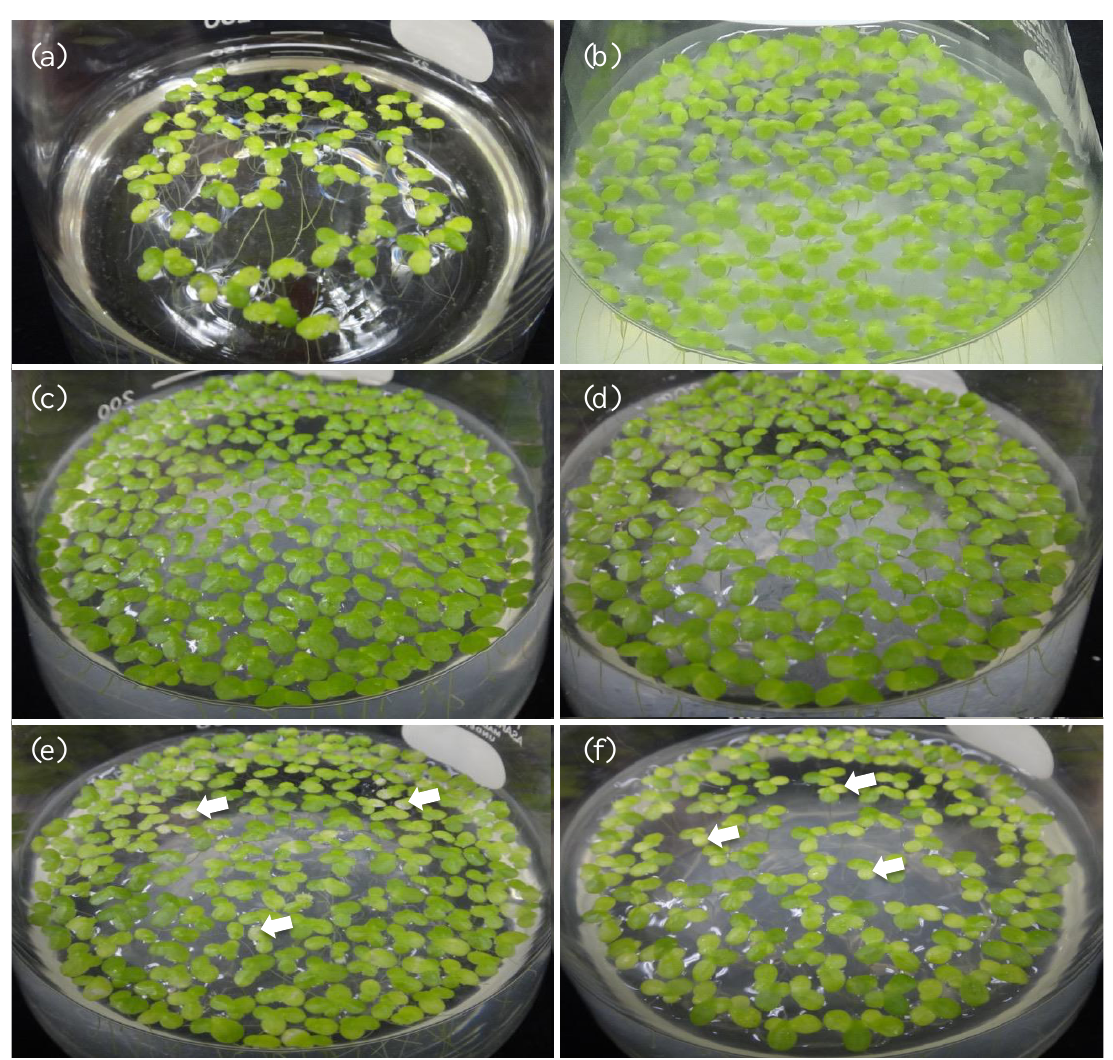
Figure 2. Growth-promotion effects of the obtained strains MRB1 – 4 on duckweed fronds after co- cultivation. The photographs show ( a ) aseptic duckweed, and aseptic duckweed co-cultured on day 14 with ( b ) Acinetobacter calcoaceticus P23, a known PGPB, as a positive control strain, or with our strains ( c ) MRB1, ( d ) MRB2, ( e ) MRB3, and ( f ) MRB4. The typical light-colored daughter fronds are indicated by white arrows.